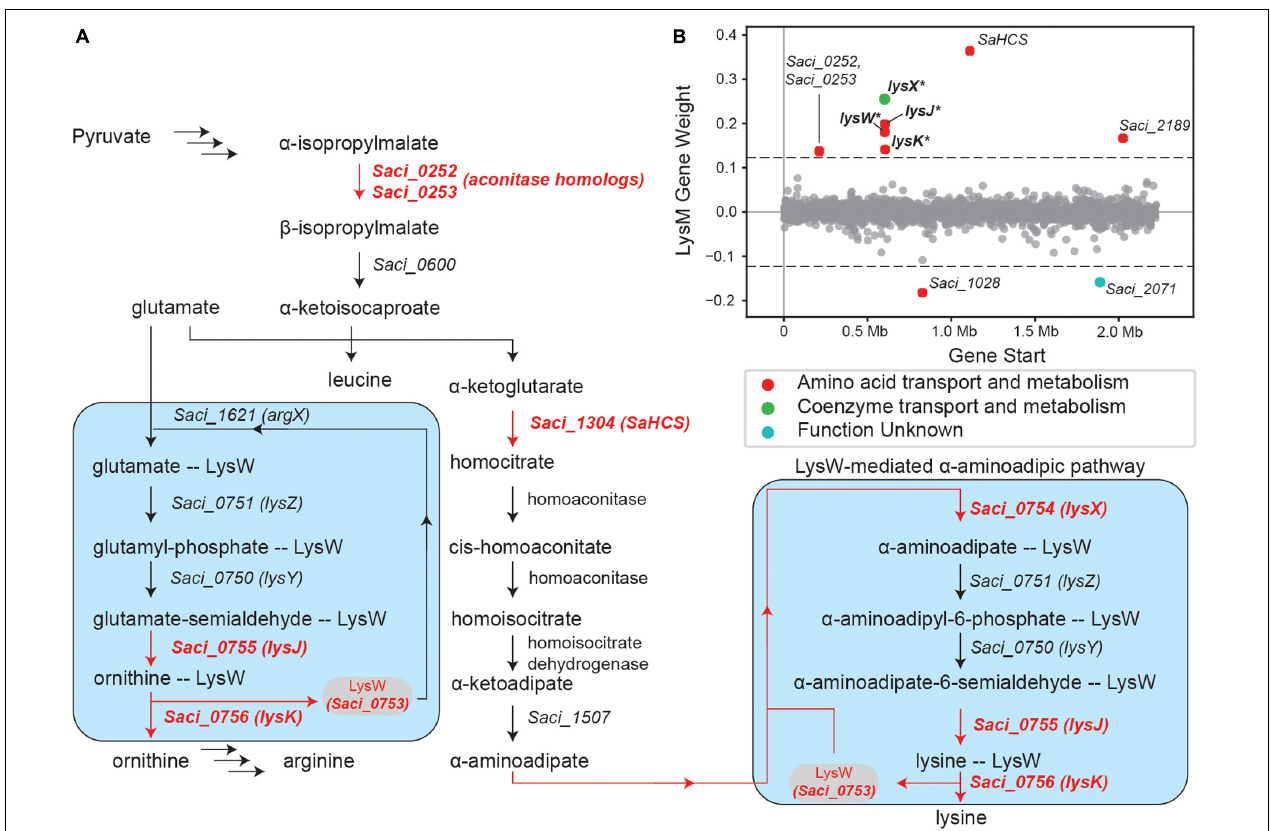
FIGURE 3 | Overview of the LysM regulon and iModulon. (A) Pathway map overviewing lysine biosynthesis in S. acidocaldarius (Ouchi et al., 2013; Suzuki et al., 2020). Genes in red are part of the LysM iModulon. The blue boxes specifically show the LysW-mediated pathway used in lysine and arginine biosynthesis which consists of lysYZMWXKJ (Zabriskie and Jackson, 2000; Ouchi et al., 2013; Suzuki et al., 2020). LysW attaches to the amino group of glutamate/ α -aminoadipate until the substrate forms into ornithine/lysine, respectively (Ouchi et al., 2013). (B) Scatter plot of the gene weights for the LysM iModulon. Genes are colored by COG categories. Genes with an asterisk “*” are part of the known LysM